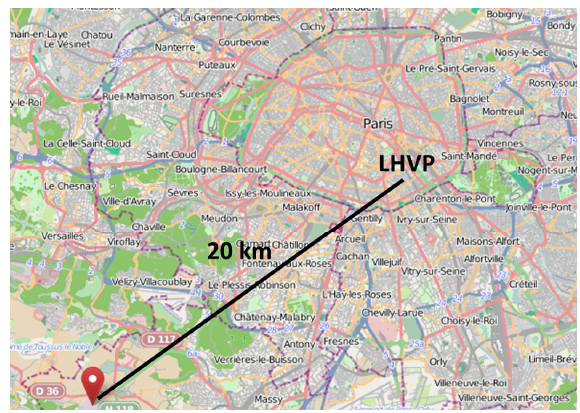
Fig. 2. SIRTA measurement platform, 20km southwest of the other measurement station (LHVP), situated in Paris centre.